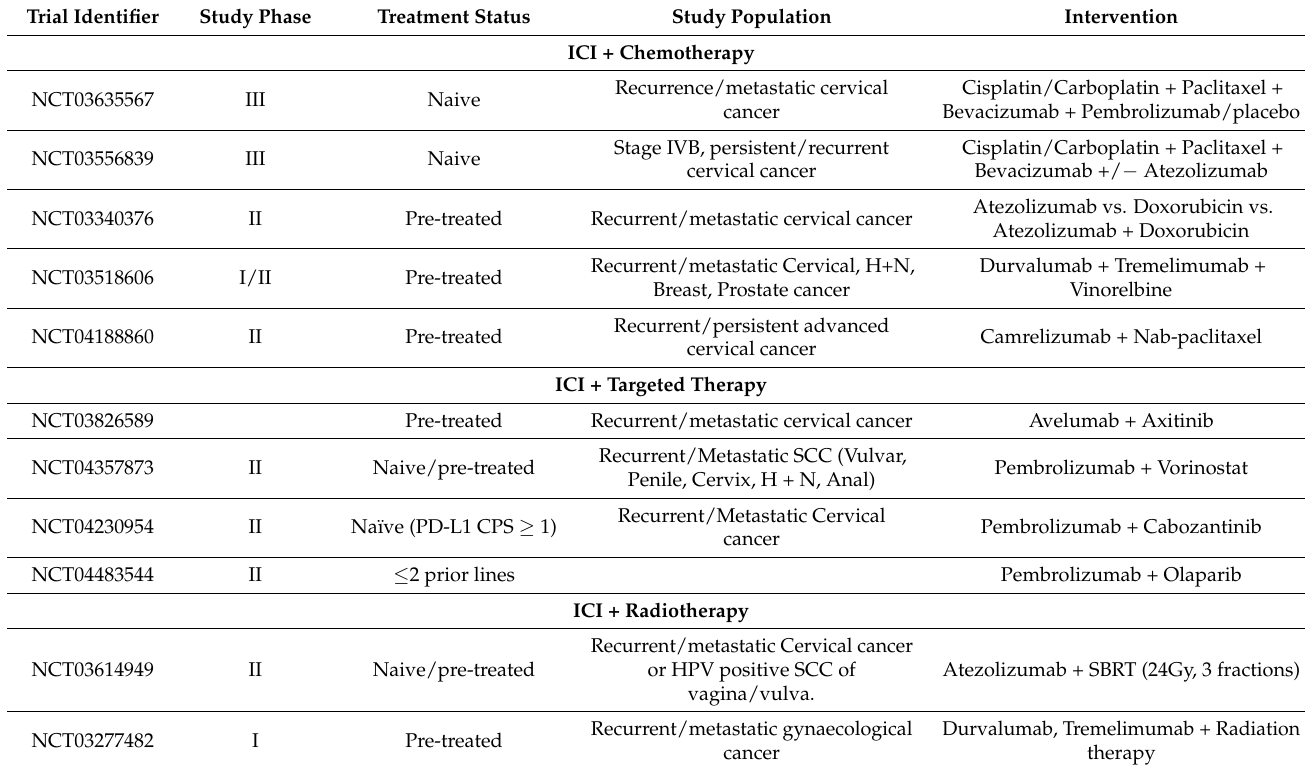
Table 3. Selected ongoing trials in advanced and metastatic cervical